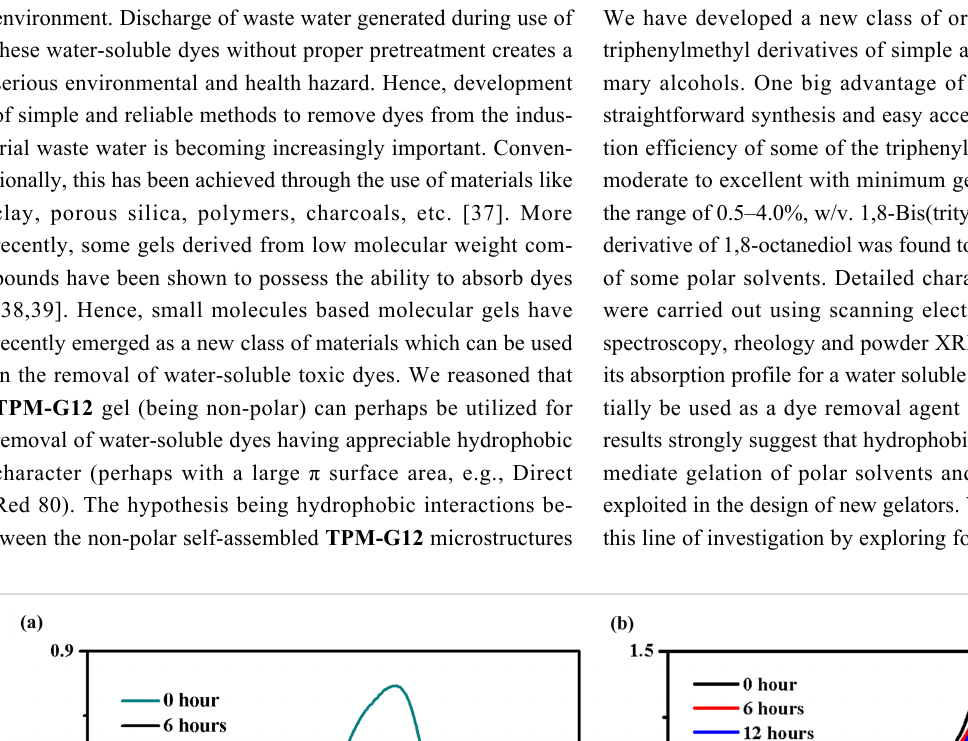
(Figure 9b). One possible arrangement is an interdigitated bilay- er structure. The molecules are oriented side by side such that each hexadecyl alkyl chain is sandwiched between two such chains. The high-intensity peak at 12.75° (d-spacing value of 6.93 Å which is comparable to the width of TPM-G5 , 6.99 Å) can be attributed to the distance between adjacent linear molec- ular arrays and also between two-dimensional planar arrays. The weak intensity peak at 22.39° (3.96 Å) can be attributed to the presence of π – π stacking between benzene rings of adjacent triphenylmethyl